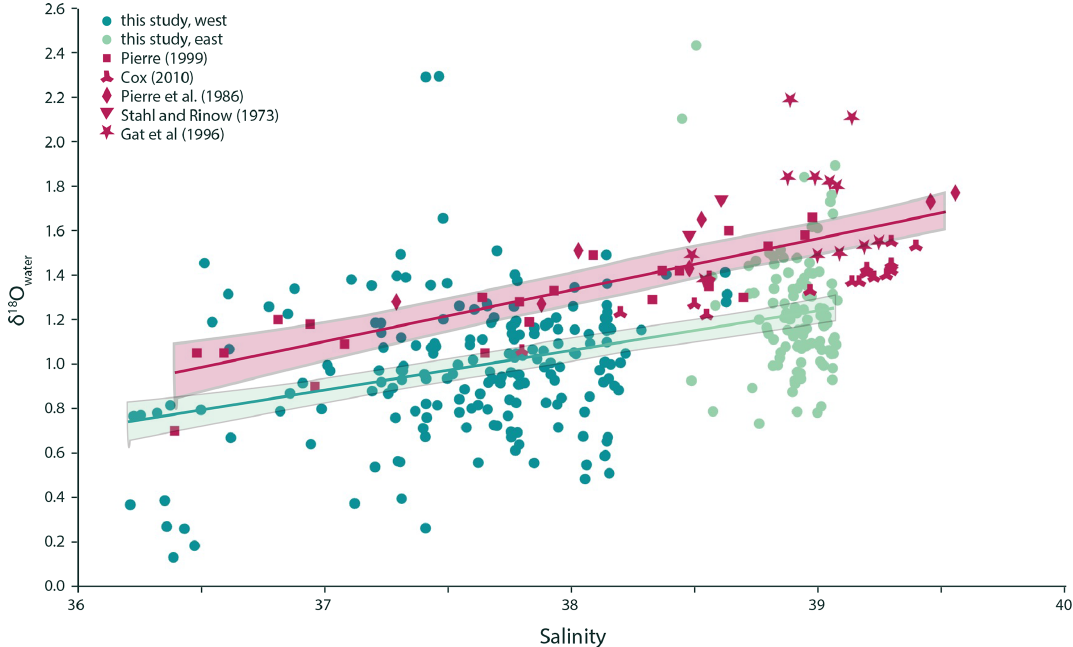
Figure 2. Surface seawater δ 18 O is positively correlated with sea surface salinity in the Mediterranean Sea, and the relationship observed can be described as linear regression δ 18 O water = 0 . 17 × S − 5 . 39 ( p value < 0.001, adjusted R 2 = 0 . 17). Previously published data can be combined into one dataset with a similar relationship with a slightly steeper slope, which is offset towards relatively higher δ 18 O ( δ 18 O water = 0 . 22 × S − 7 . 19; p value < 0.001, adjusted R 2 = 0 . 48). The two regression lines are significantly different from each other (ANOVA p value < 0.01).